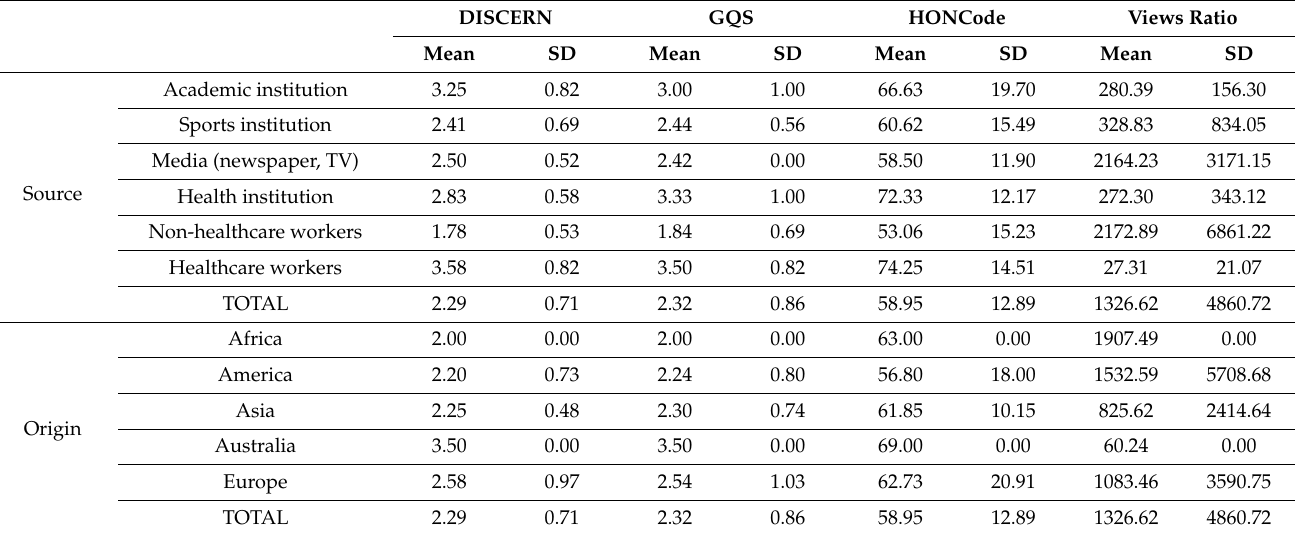
Table 3. Author and origin variables related with DISCERN, GQS, HONCode, and views